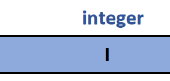
Figure 3. Fixed-point